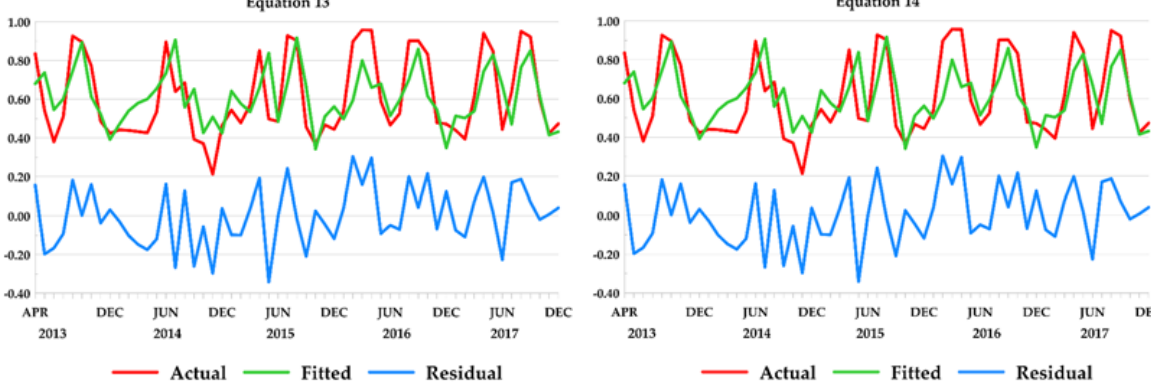
Figure 5. Representation for type 2 maize, estimation model and the residuals given by Equations (13) and (14). A similar model considering the dynamic structure of the time series and by means of transference functions is presented in Equation (14). The selected model was ARI-